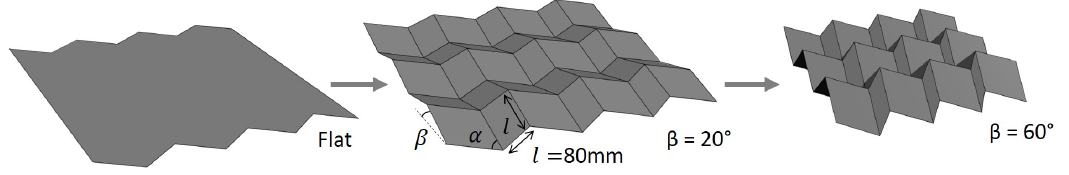
Figure 2. Miura-ori based FSS design. Demonstrating intermediate fold angles of β = 0°, 20°, and 60°, corresponding projected area change of A / A o = 1, 0.94,